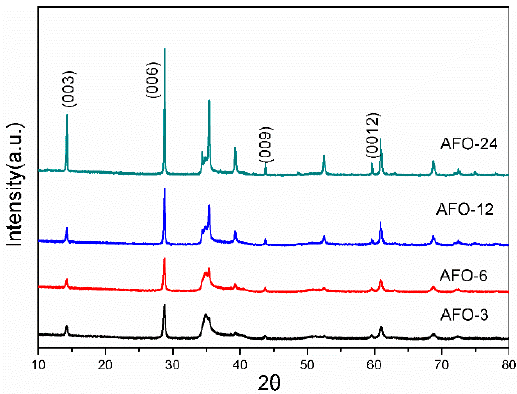
Figure 1. XRD patterns of as-prepared AgFeO 2 samples with different reaction times.